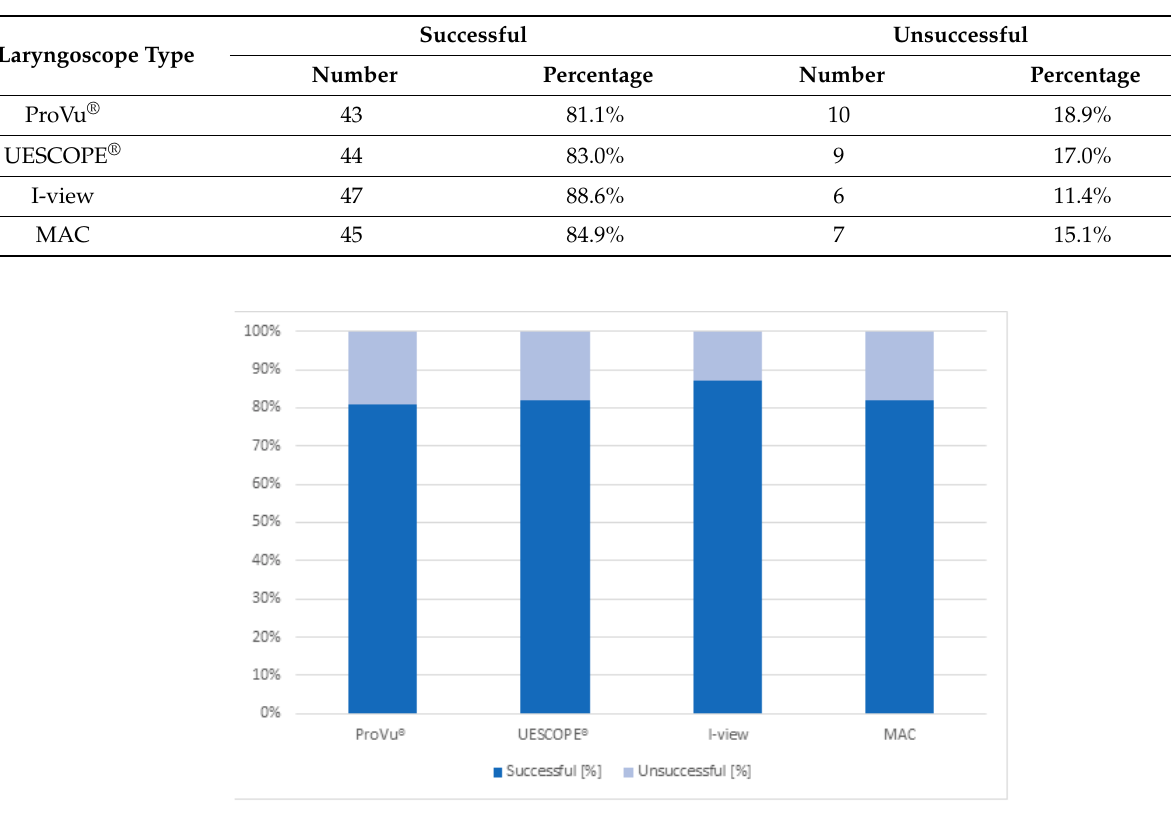
Figure 5. Number of successful and unsuccessful intubation a tt empts.